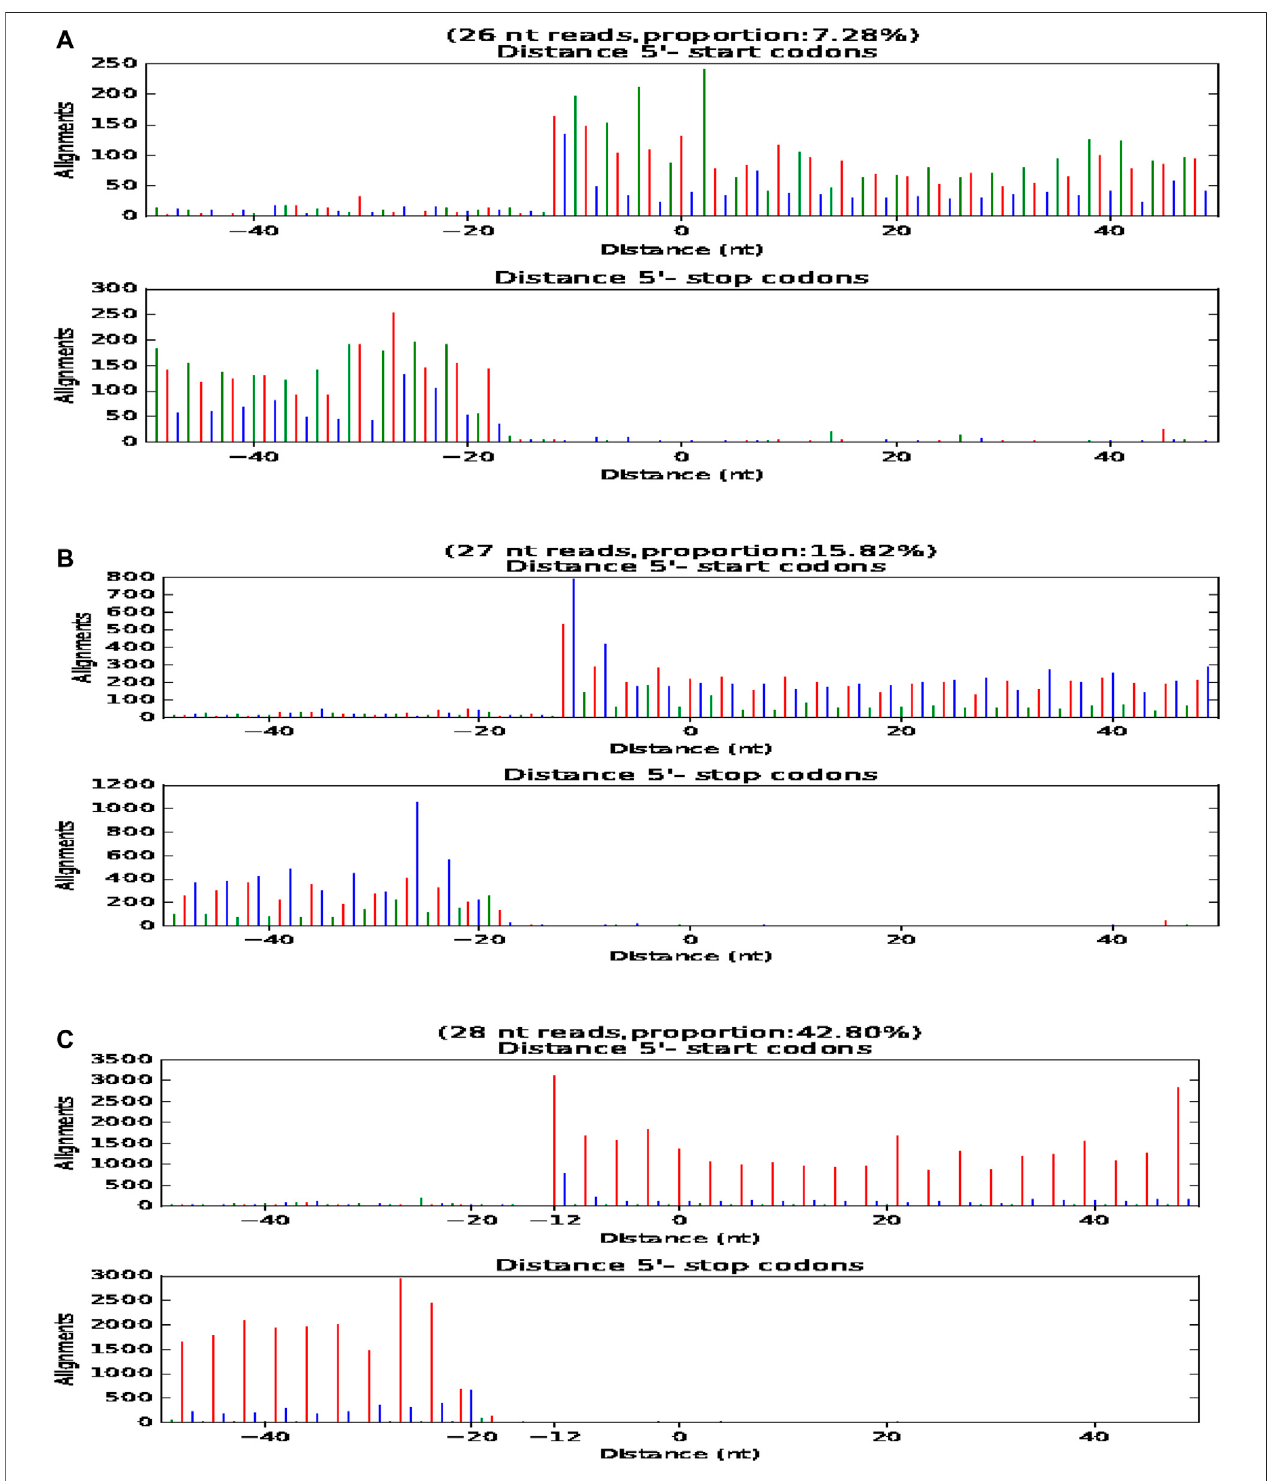
FIGURE 6 | P-site map of fi ne type and coarse type LCG. The abscissa is the distance from the start code or stop code, and the ordinate is the reads on the comparison. (A – C) P-site map of three fi ne type samples of LCG. (D – F) P-site map of three coarse samples of LCG.